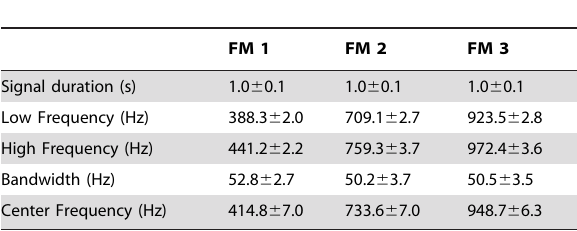
Table 1. Summary of OAWRS FM pulse characteristics (mean 6 SD), as measured from spectrograms (FFT: 512 samples, Hanning window, 75% overlap) and waveforms of MARU recordings on October 1–3, 2006 (sample rate: 2000 Hz, recording depth: 30–40 m).